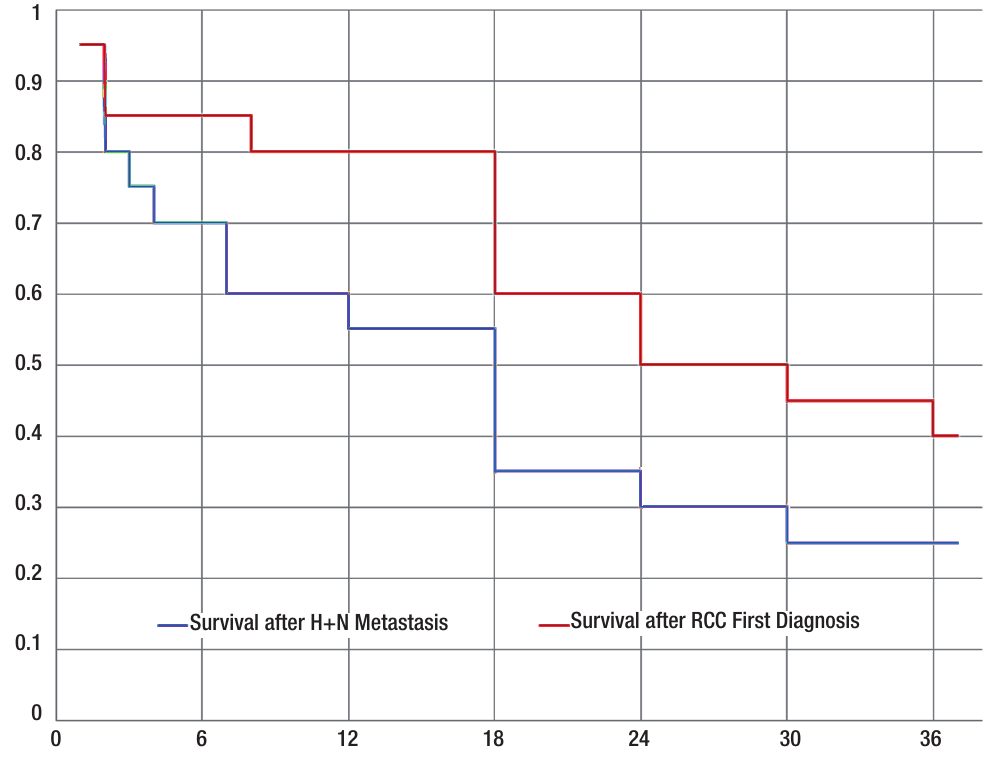
Figure 2 - Survival after diagnosis of a head and neck metastasis, shown in months with standard